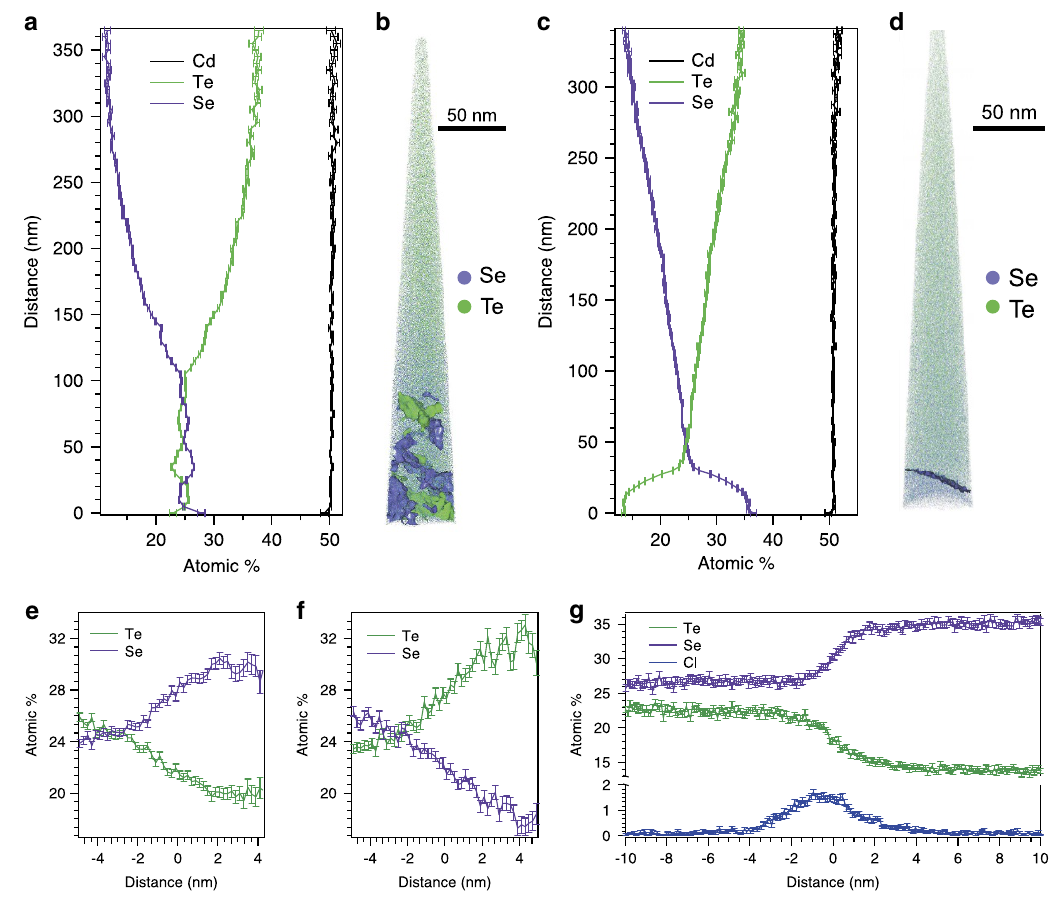
Figure 5 | Compositional variations at the nanoscale. ( a ) A 1D line profile in the z direction of the ( b ) APT 3D reconstructed data set for the 100nm CdSe layer sample displaying the Te (green) and Se (purple) atoms, and 27.5% Te (green) and Se (purple) isosurfaces. ( c ) A 1D line profile in the z direction of the ( d ) APT 3D reconstructed data set for the 400nm CdSe layer sample displaying the Te (green) and Se (purple) atoms, and a 24% Se isosurface. Proximity histograms for the 27.5% Te ( e ) and Se ( f ) isosurfaces for the 100nm sample imaged in b . ( g ) Proximity histogram for the 24% Se isosurface shown in d . The error bars embedded in the 1D line profiles and proximity histograms are the s.e. ( s ) from counting statistics, s ¼ of the element and N is the total number of ions. Minor uncertainties can occur from background levels and mass spectral peak overlaps. A detailed summary of the mass spectrum, mass spectral ranges and resulting compositions can be found in Supplementary Fig. 4 and Supplementary Table